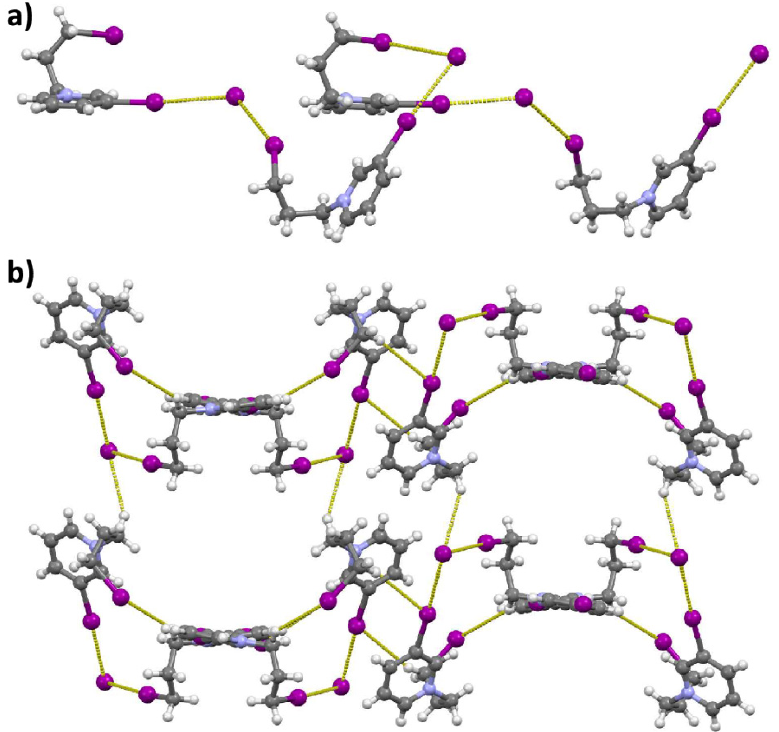
Figure 6. ( a ) [ N -I Prop - 3-IPy ] + cations and iodide anions connected through C − I ⋯ I − halogen bonds in chains in the structure of [ N -Et- 3-IPy ]I; ( b ) Neighbouring chains are further interconnected by a network of C − H ⋯ I − and C − H ⋯ I contacts into a 3D structure.